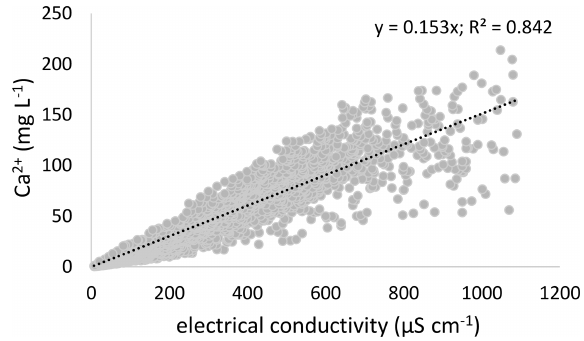
Figure 1. The final regression model to impute Ca 2 + values based on electrical conductivity (EC; µScm − 1 ; n =